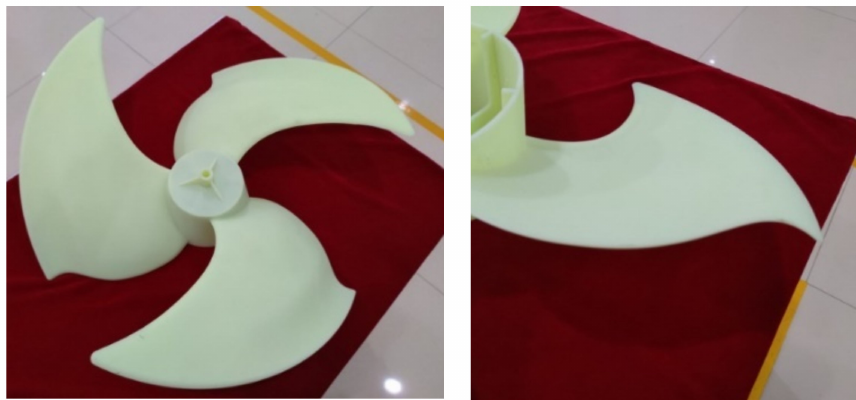
Figure 14. Three-dimensional print prototype of case-10.